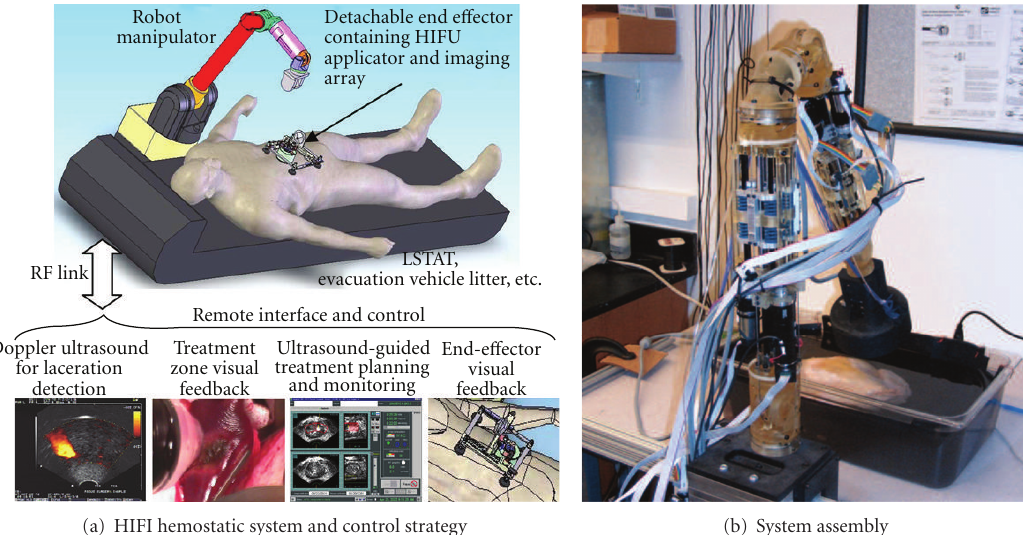
Figure 8: (a) Schematics of the LSTAT/CSTAT compatible, remotely operated HIFU hemostatic system (top) and the overview of its control strategy (bottom) [17]. (b) The same system’s assembly and experimental setup at the Brigham and Women’s Hospital